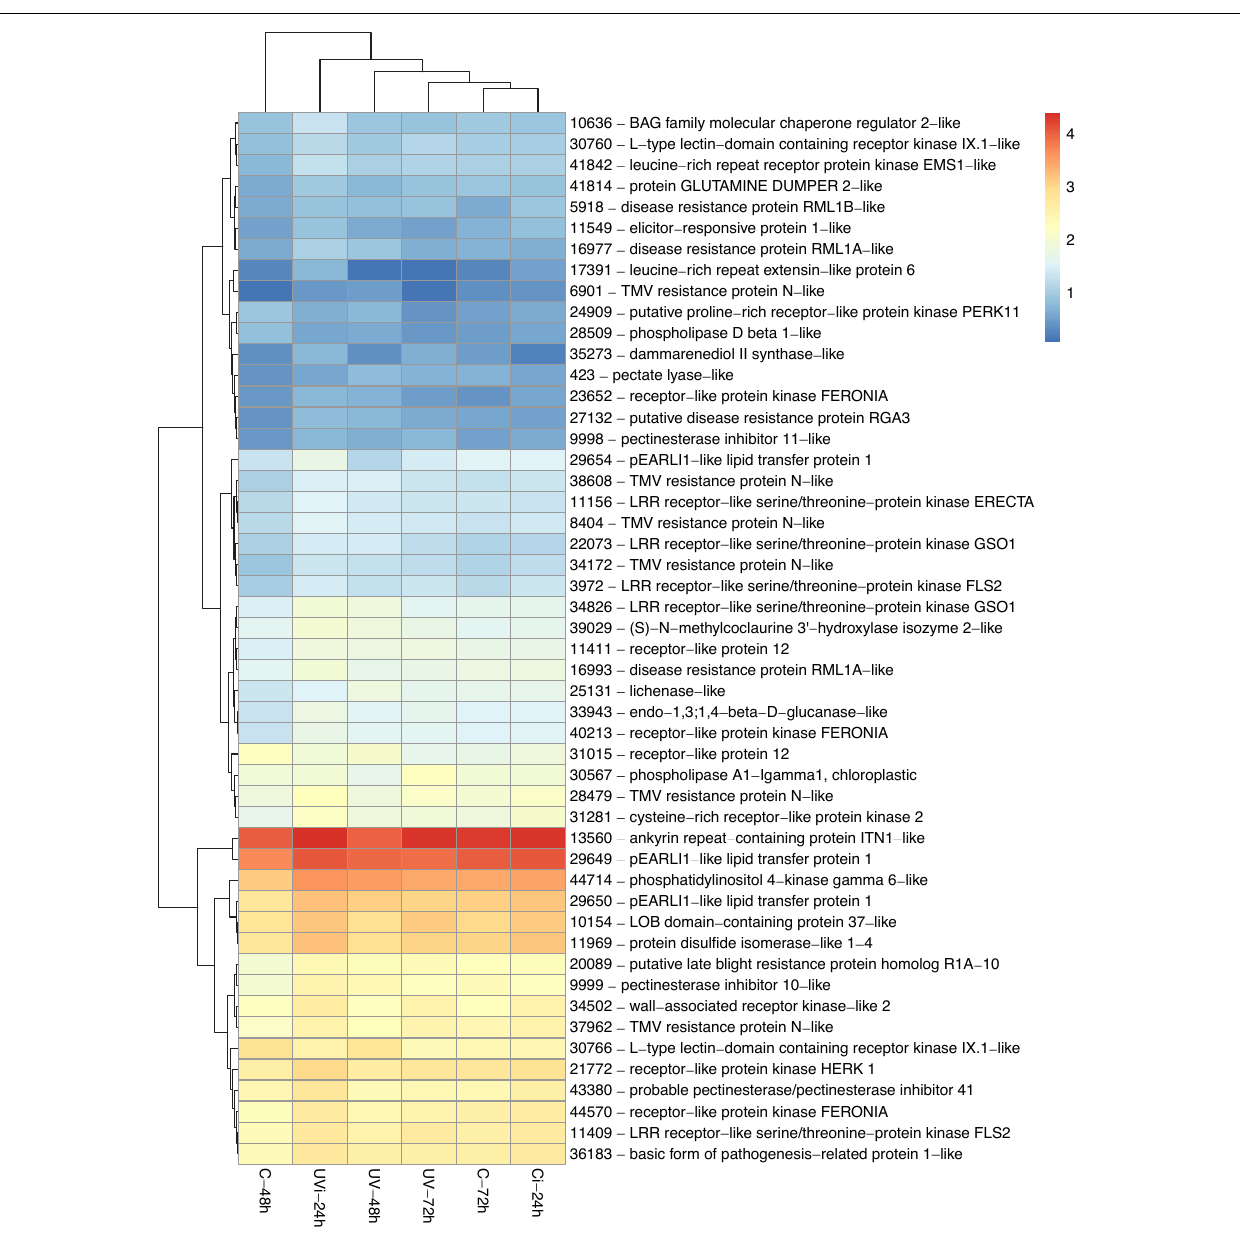
FIGURE 4 | Genes related to defense mechanisms differentially expressed in response to UV and Xcv inoculation. Test of hierarchical DEG (HCA) groupings. The colors reflect the level of relative gene expression. The columns and rows represent the samples and ID_genes associated with the name/function of the corresponding protein that were grouped according to their relative expression profile, respectively. C-48 h, control corresponding to treated 48 h after UV; UV-48 h, UV after 48 h treatment; C-72 h, control corresponding to treated 72 h after UV; UV-72 h, UV after 72 h treatment; Ci-24 h, control 24 h after inoculation; UVi-24 h, UV 24 h after inoculation. The genes were filtered out with a threshold |log2-FC| > 1.5 and FDR <